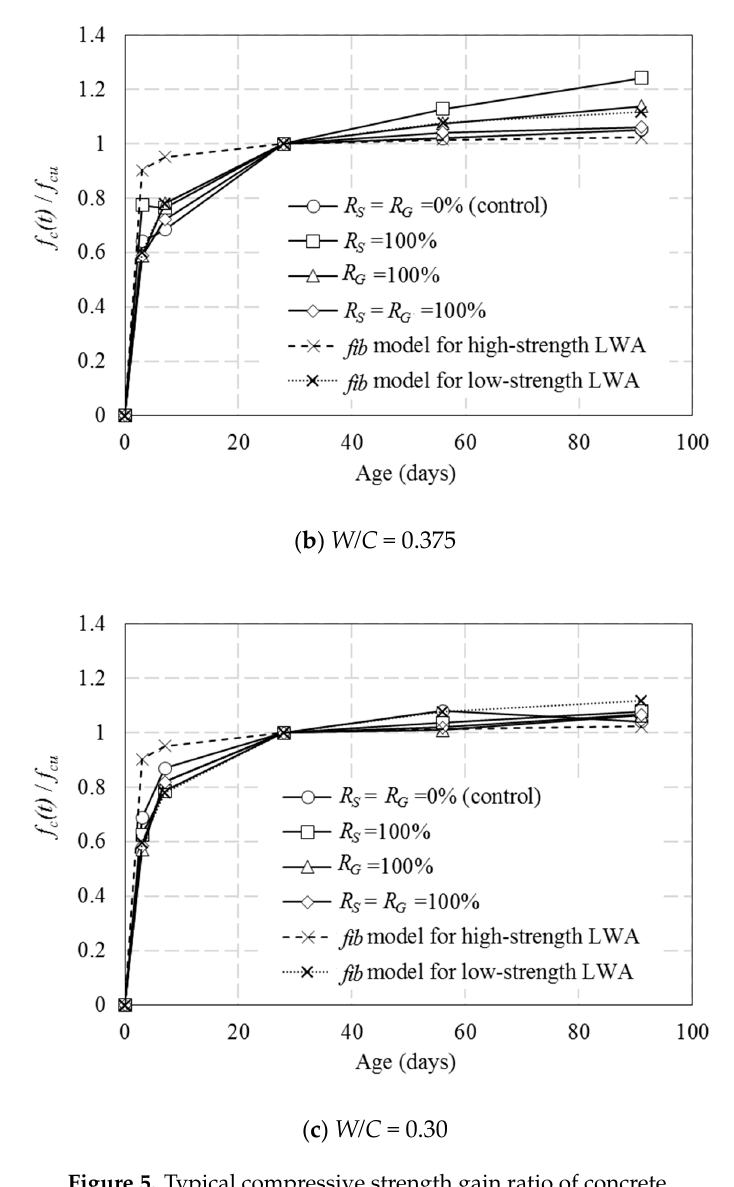
Figure 5. Typical compressive strength gain ratio of concrete.